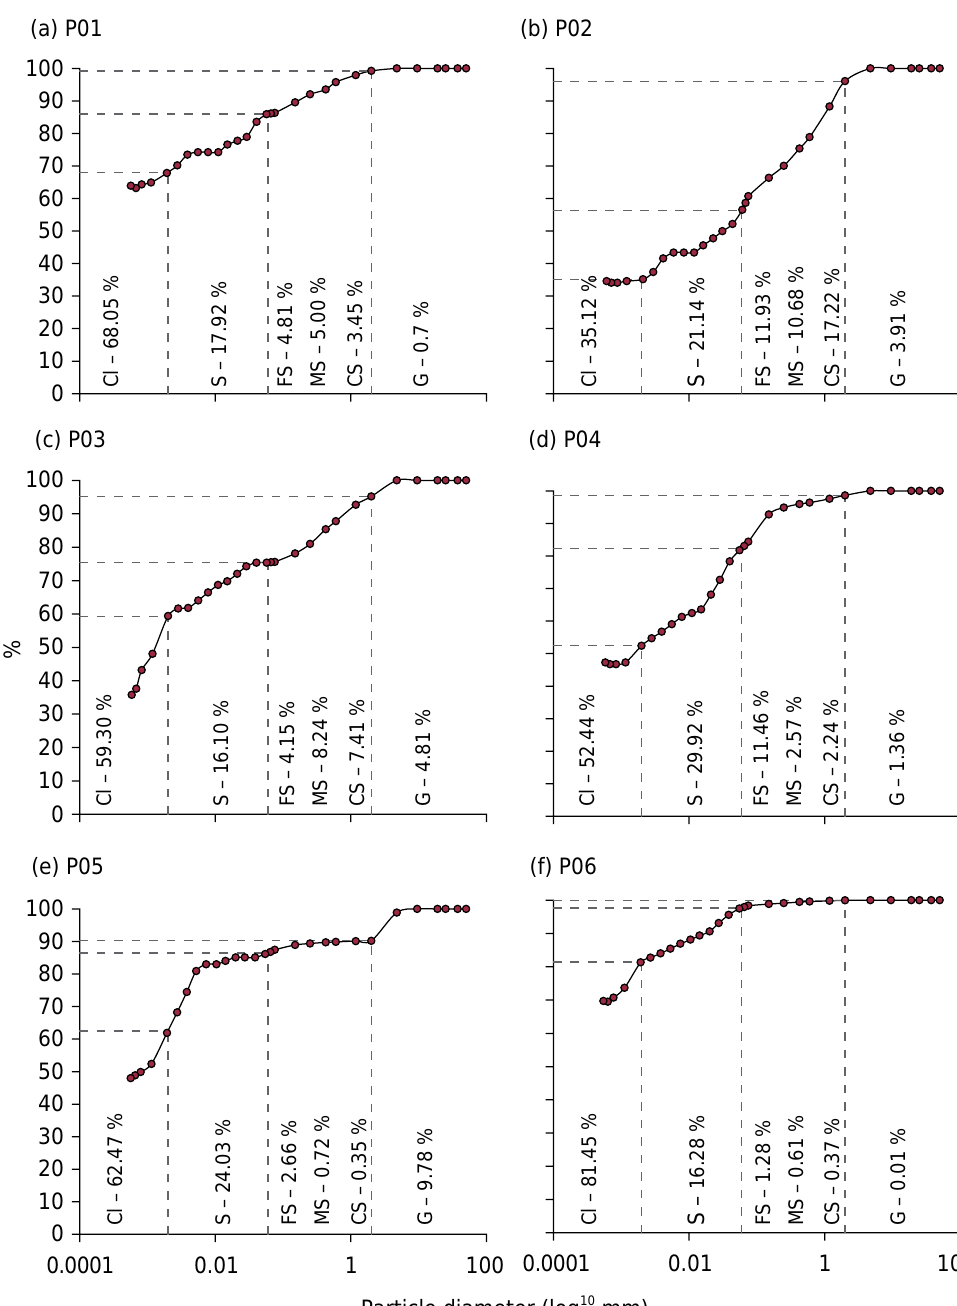
Figure 2. Granulometric curves of Vertisols in Bahia State (Cl: clay; S: silt; FS: fine sand; MS: medium sand; Cs: coarse sand; G: